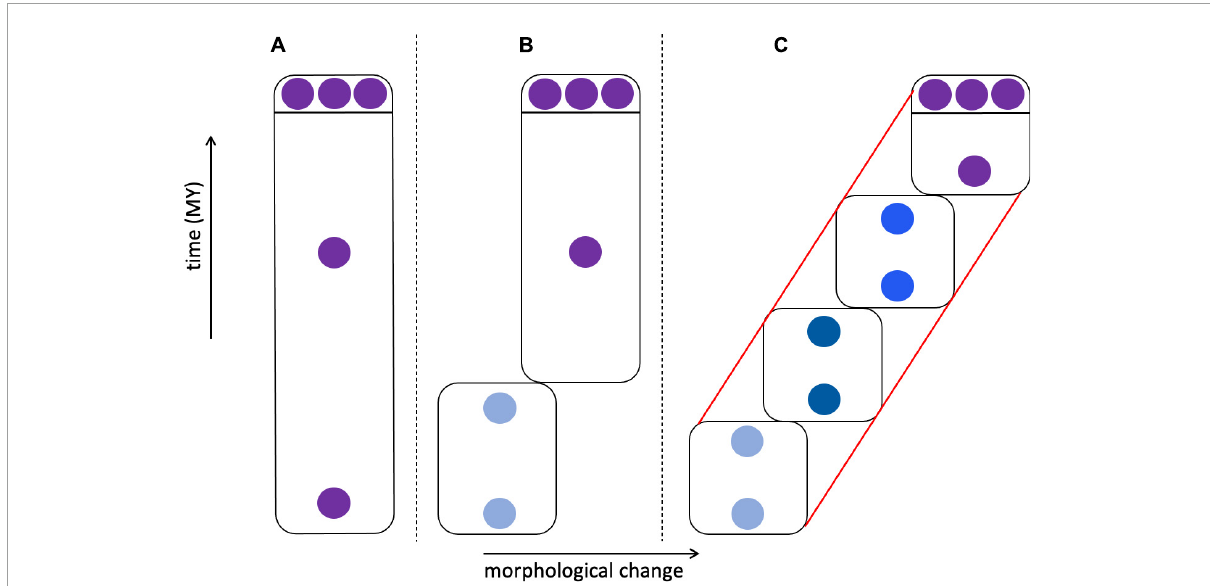
FIGURE5 Morphological change in species through time. In (A–C) three individuals sampled from an extant species are shown at the top, above the line, with fossil individuals below the line; fossils are either morphologically identical to modern individuals or differ from them to varying degrees. (A) Fossil and modern individuals are similar enough that they are classified as the same species. (B) Fossils exist that are identical to modern individuals, but deeper in the fossil record these are replaced by individuals that lack apomorphic (derived) characters. This could lead to the recognition of two chronospecies, with the modern species marked by autapomorphies. (C) A relatively complete fossil record links early fossils through a series of transitional forms leading to the modern species with its set of autapomorphies. This could lead to the recognition of one species (red lines) showing anagenesis, four chronospecies (boxes), or some intermediate number of taxa. (B) vs. (C) represent punctuated vs. gradual speciation